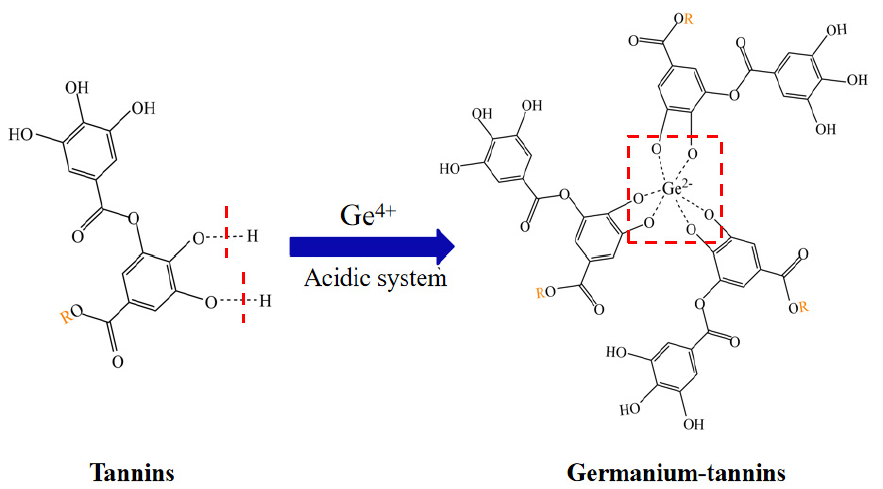
Figure 13. Simple mechanism diagram of tannin–germanium complex.